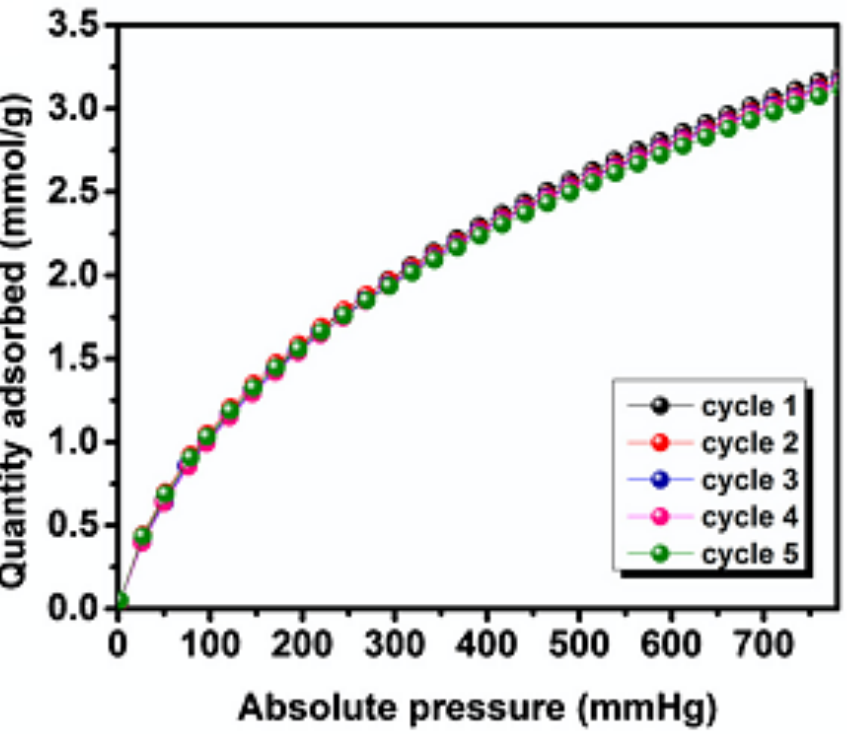
Figure 44. CO 2 adsorption of N- and S-doped benzoxazines over 5 cycles (reproduced from the work in [109] with permission).